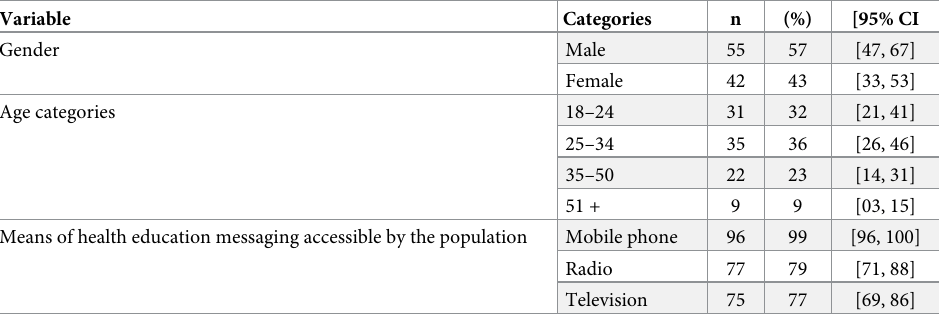
Table 2. Summary of patients with dengue fever (n =